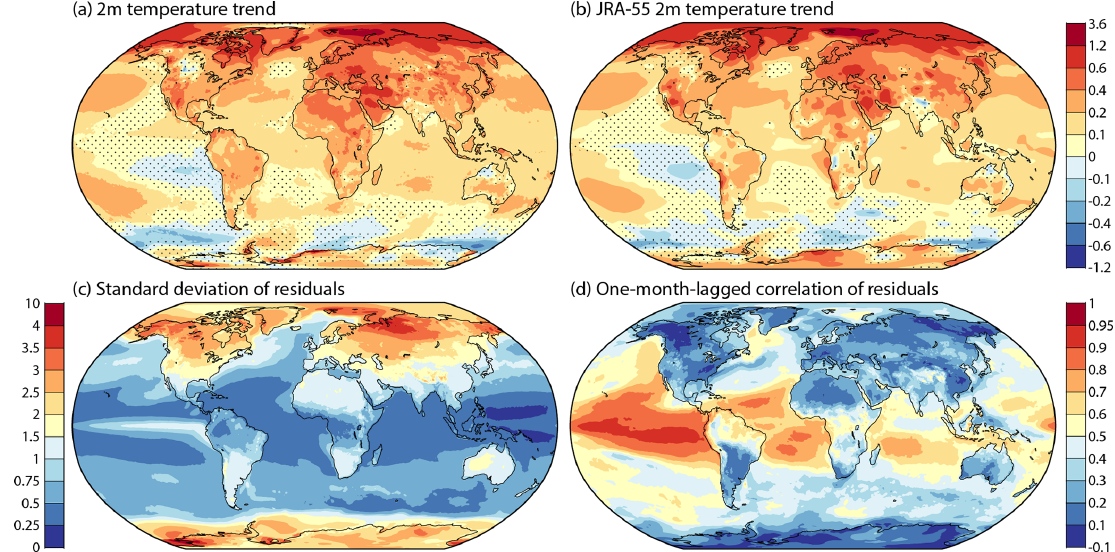
Figure 2. (a) The least squares fit linear trend (K per decade) in 2m temperature based on monthly average ERA5 data from March 1979 to February 2022. (b) As (a) but for JRA-55. Dots show where the 95% confidence interval is two-signed. (c) The standard deviation of residual differences between 2m temperatures and their fitted values (K). (d) The correlation coefficient between successive monthly residuals. Table 1. Least squares linear trends in monthly mean surface-air temperatures (K per decade) and the range of the 95% confidence in- tervals for six continental averages for the period from March 1979 to February 2022 for the ERA5 analysis (an) and background (bg) and three other datasets. The continental areas are defined as all land within the following ranges: Europe (35–80 ◦ N, 20 ◦ W–40 ◦ E), Asia (0–85 ◦ N, 60–180 ◦ E), North America (15–85 ◦ N, 170–50 ◦ W), Africa (40 ◦ S–35 ◦ N, 25 ◦ W–55 ◦ E), Australia (50–10 ◦ S, 110–160 ◦ E) and South America (65 ◦ S–15 ◦ N, 90–25 ◦ W). Global and Arctic averages are also shown; for GISTEMP and HadCRUT5 they are based on sea-surface temperature and not air temperature over ice-free